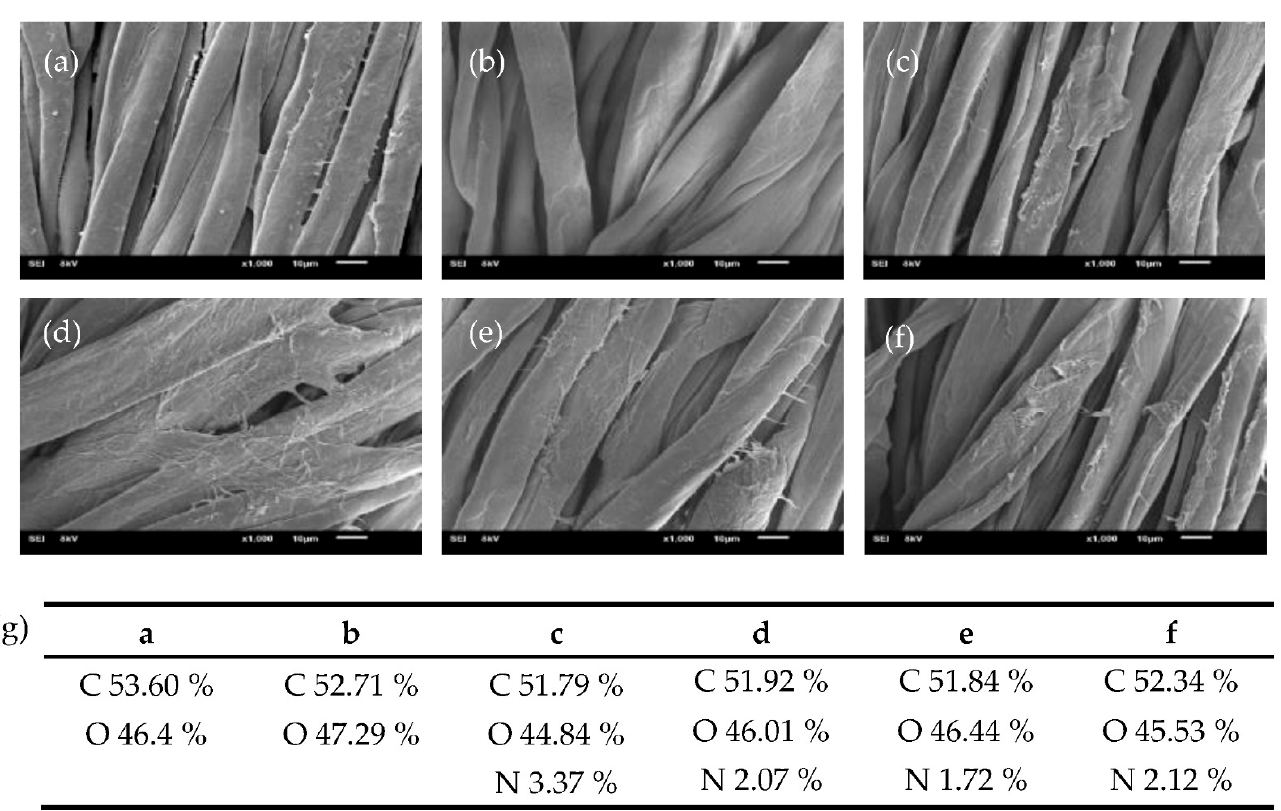
Figure 4. SEM images (10 μ m) obtained at 8 kV acceleration voltage: ( a ) raw cotton fabric, ( b ) treated cotton fabric, ( c ) EDA-CDs/CF, ( d ) MIPs/MT@EDA-CDs/CF, ( e ) MIPs@EDA-CDs/CF, ( f ) NIPs@EDA-CDs/CF, and ( g ) EDS analysis of each cotton fabric.